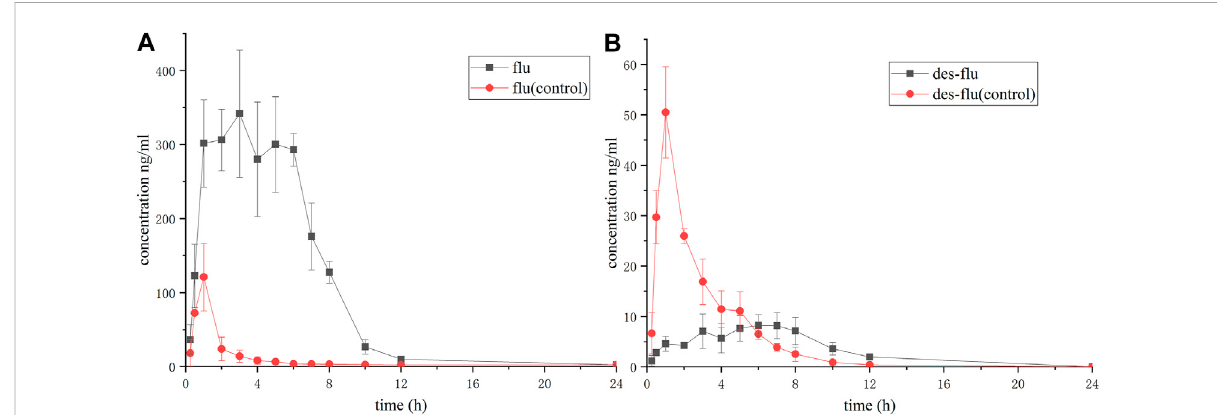
FIGURE 3 Concentration-time curve of fl uvoxamine and its metabolite. The rats were administrated with fl uvoxamine via gavage. As follows, the tail vein blood was collected, and was subjected to UPLC-MS/MS assay. (A) Desmethyl fl uvoxamine, (B) Fluvoxamine. The curve was plotted using Prism 5, n =